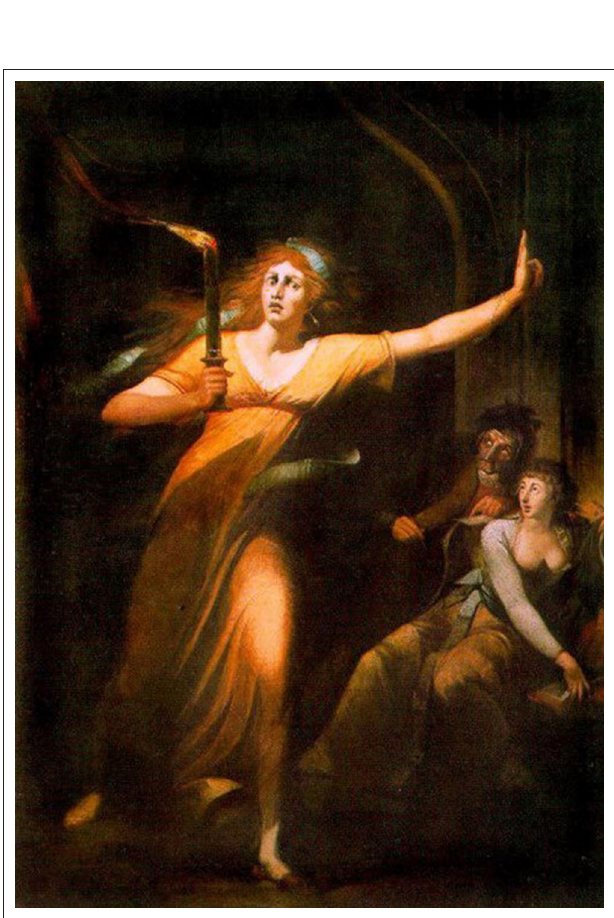
FIGURE 2 | The Sleepwalking of Lady Macbeth by Johann Heinrich Füssli (1781–1784) (Musée du Louvre). Free